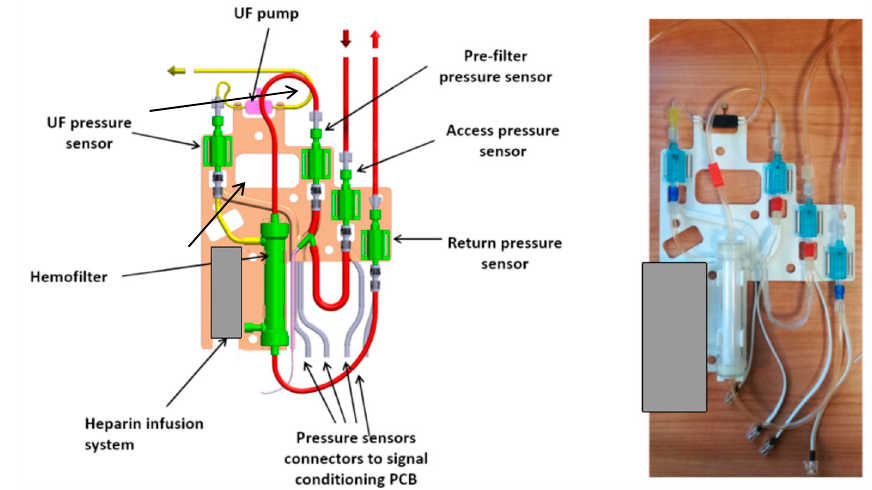
Figure 4. External panel with the disposable components of the RAP: 3D sketch and manufactured prototype.